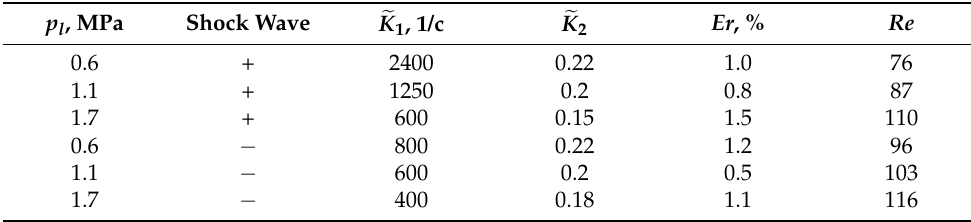
Table 3. Coefficients of the mathematical model at M = 2.5.